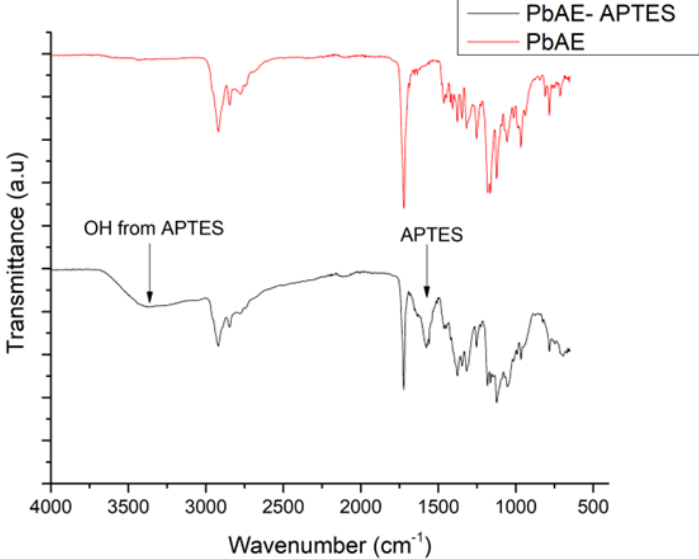
Figure 2. FTIR spectra of poly(β -amino esters) with and without APTES.